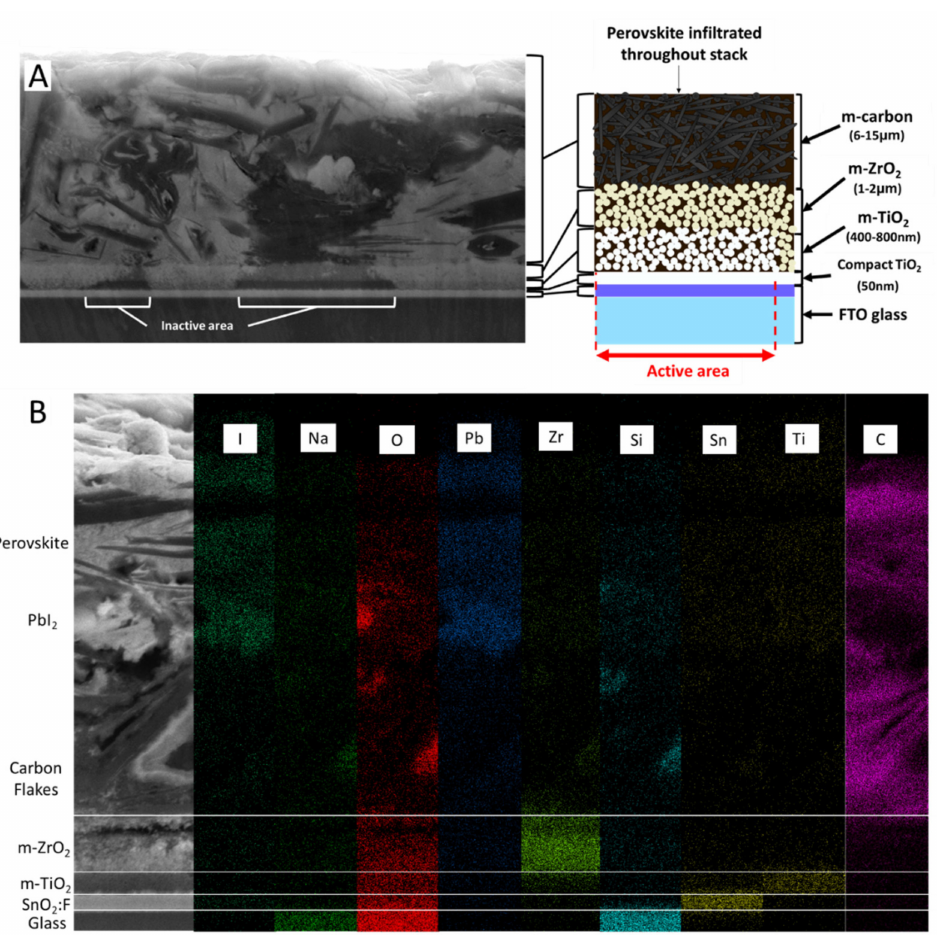
Figure 4. ( A ) Cross section and schematic of the full perovskite carbon stack with inactive areas identified. ( B ) EDS pattern of the triple stack clearly showing the printed